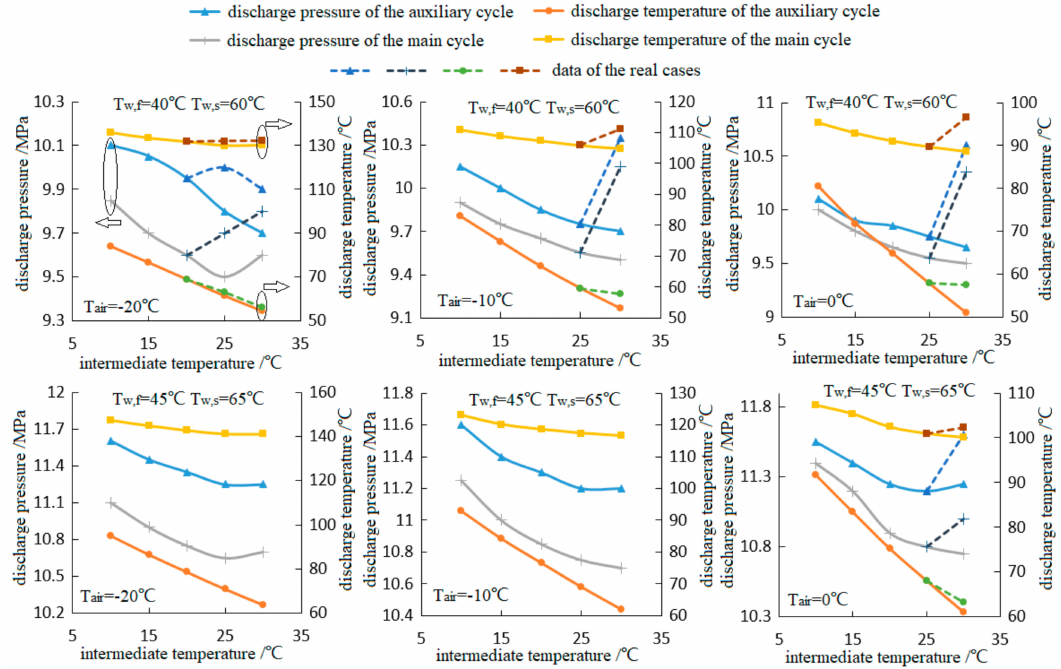
Figure 9. The discharge pressure / temperature in both cycles versus the intermediate temperature at 40 ◦ C / 60 ◦ C in water-feed / supply